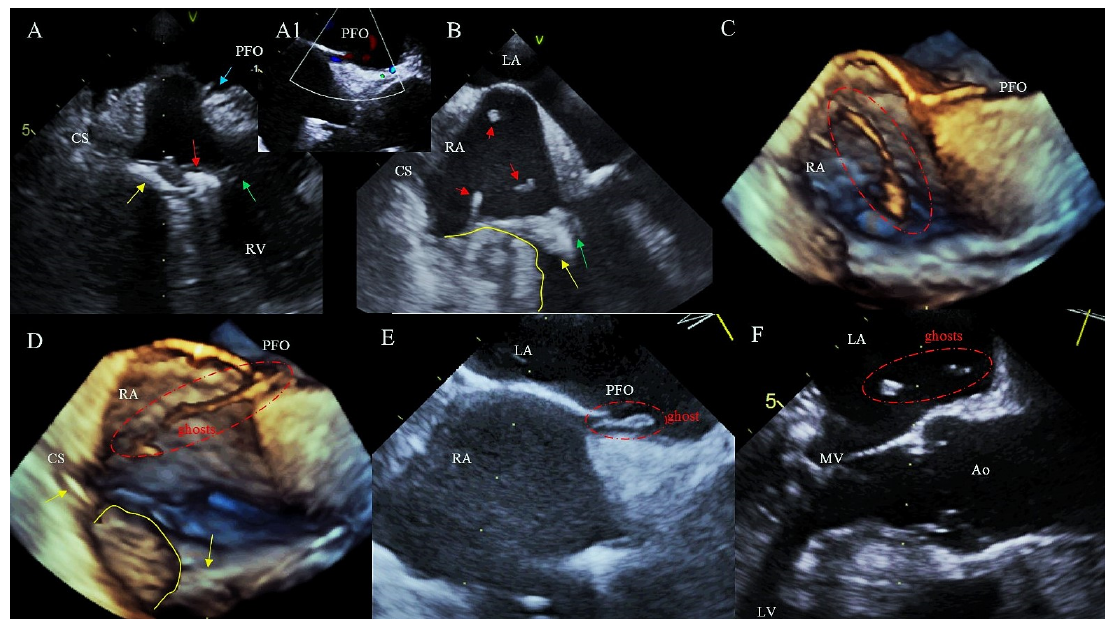
Figure 4. Flying ghosts that travelled to the systemic circulation through the PFO imaged by 2D, 3D TEE ( A ) Coronary sinus lead extraction (yellow arrow) (CS). Encapsulating scar tissue (red arrow) dissected away from the pacing lead using the Byrd dilator sheath (green arrow). ( B ) Pieces of scar tissue (FG) (red arrow) freed during lead dissection. Pulling on the cardiac wall (yellow line) during extraction of the adherent lead. ( C ) FG, freed from the lead, floating in the RA. ( D , E ) The same FG passing through the PFO. ( F ) FG in the LA.